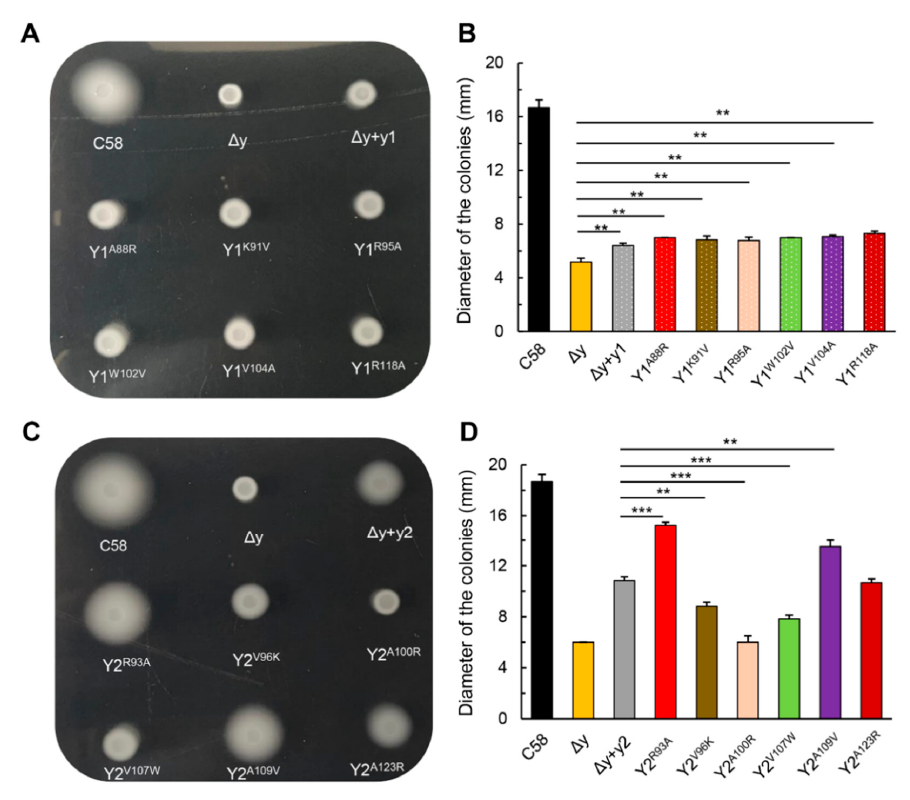
Figure 5. Effects of the single residue substitution of the key residues in the motor binding surface of CheY on the function of CheY in recovering the chemotactic migration of CheY-deficient mutant in the swim plate. Plasmids coding various CheY variants (or native CheYs) were respectively introduced into the cheY1 - cheY2 double-deletion mutant ( Δ y) to complement the function of CheY. Equal amounts of the cells from these A. fabrum strains were inoculated on the swim agar plate and grown for 40 h at 28 °C. ( A ) and ( C ): Typical colonies of these tested A. fabrum strains. ( B ) and ( D ): The diameters of these colonies were measured to assess the activities of these CheY variants in restoring the chemotactic response of A. fabrum to nutrients. Data show the means of three biological replicates with the standard deviations. The bars connected by “**” and “***” mark mean that they are different in a statistically significant manner at p < 0.01, and 0.001, respectively, via the unpaired Student’s t test. C58, A. fabrum wildtype C58 strain; ∆ y, cheY1 and cheY2 double-deletion mutant; ∆ y+y1, ∆ y mutant complemented with cheY1 gene; ∆ y+y2, ∆ y mutant complemented with cheY2 gene; Y1 A88R , Y1 K91V , Y1 R95A , Y1 W102V , Y1 V104A , and Y1 R118A represent ∆ y mutant expressing the corresponding single residue-substituted CheY1 variants respectively; Y2 R93A , Y2 V96K , Y2 A100R , Y2 V107W , Y2 A109V , and Y2 A123R represent ∆ y mutant expressing the corresponding single residue-substituted CheY2 variants respectively.